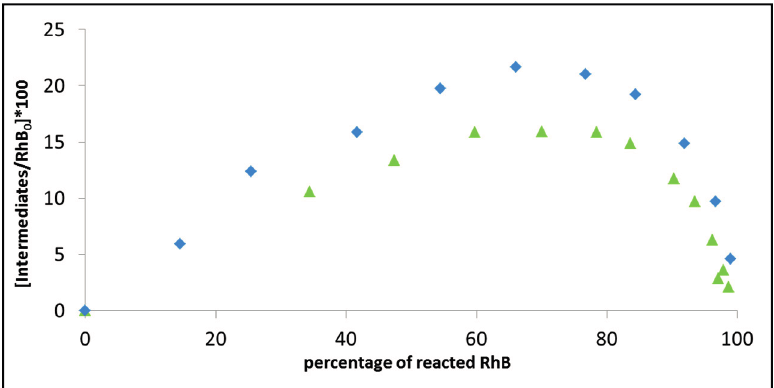
Figure 9. The progression of the photoinduced degradation of rhodamine B on BiOCl under 515 nm light, at two light intensities: 0.3 mW/cm 2 (diamonds) and 1.19 mW/cm 2